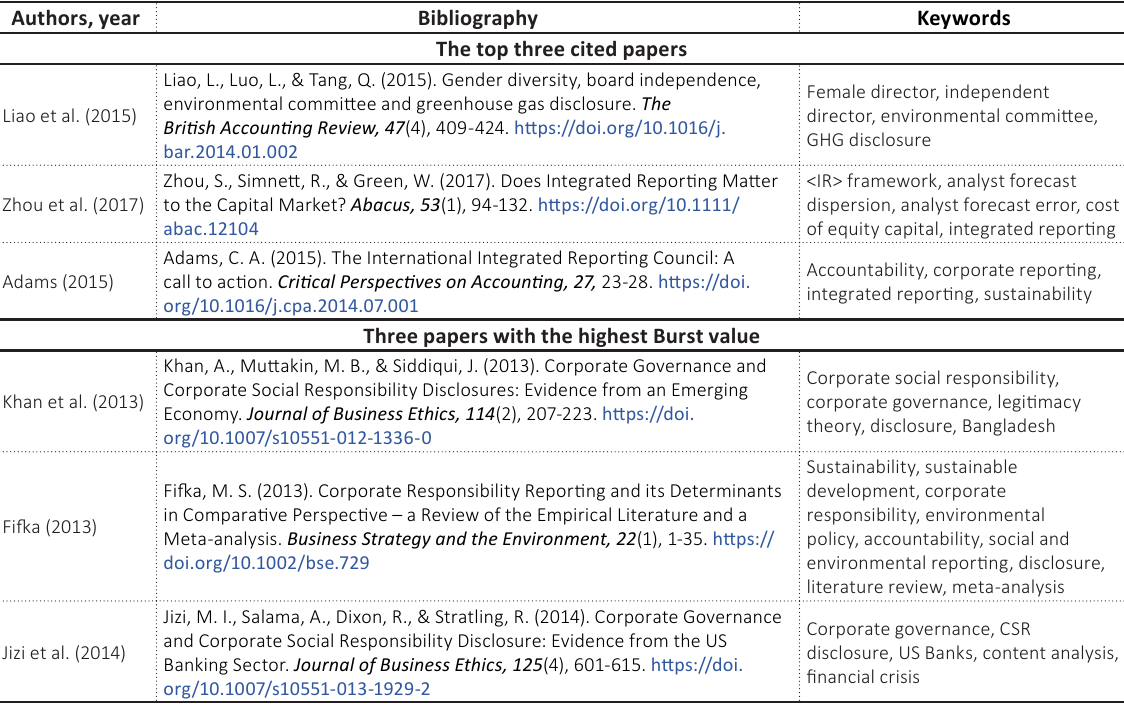
Table B1. The top three cited and three papers with the highest Burst